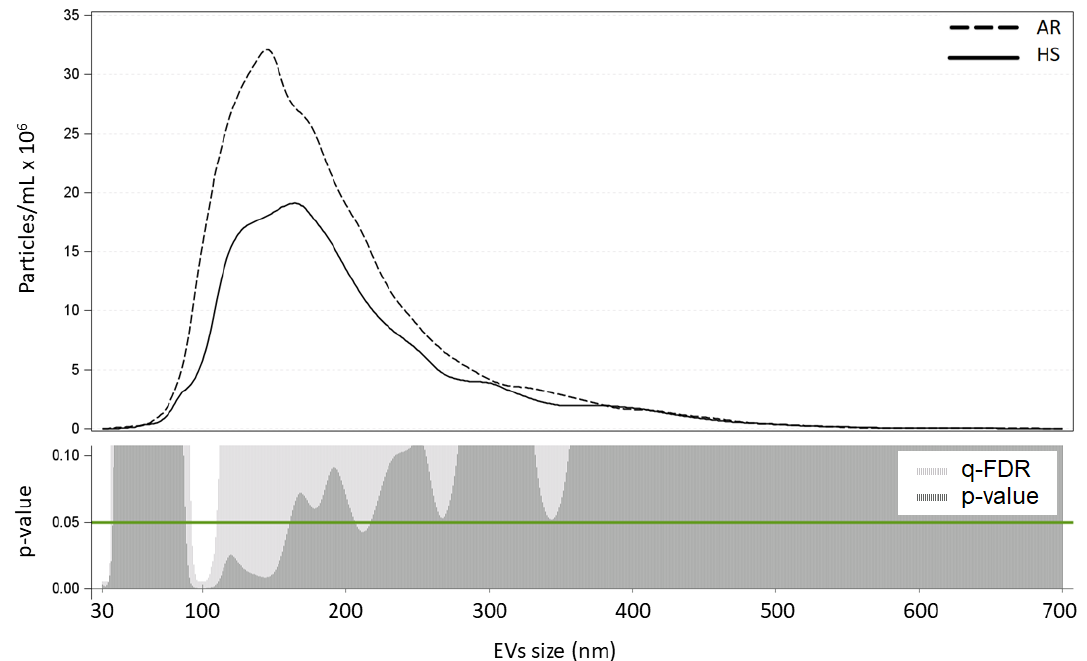
Figure 1. Number of EVs for each size (nm) in HS and AR. The upper panel of the figure reports EV concentration for each size for the AR (dashed line) and HS (solid line) groups. The lower panel reports the p and q -values of the comparisons of each size EV for the entire 30–700nm size range (AR vs. HS). EV concentrations were calculated as marginal means from a negative binomial model adjusted for age, gender, smoking habit, mean temperature, mean humidity, case-control condition, PM10 day -0, and interactions between case-control and PM exposure.